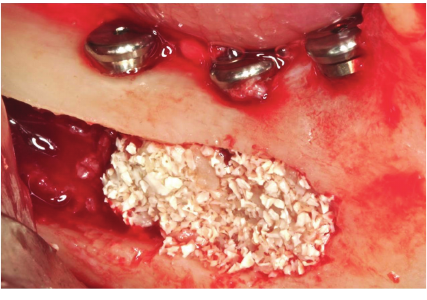
Figure 8: Filling